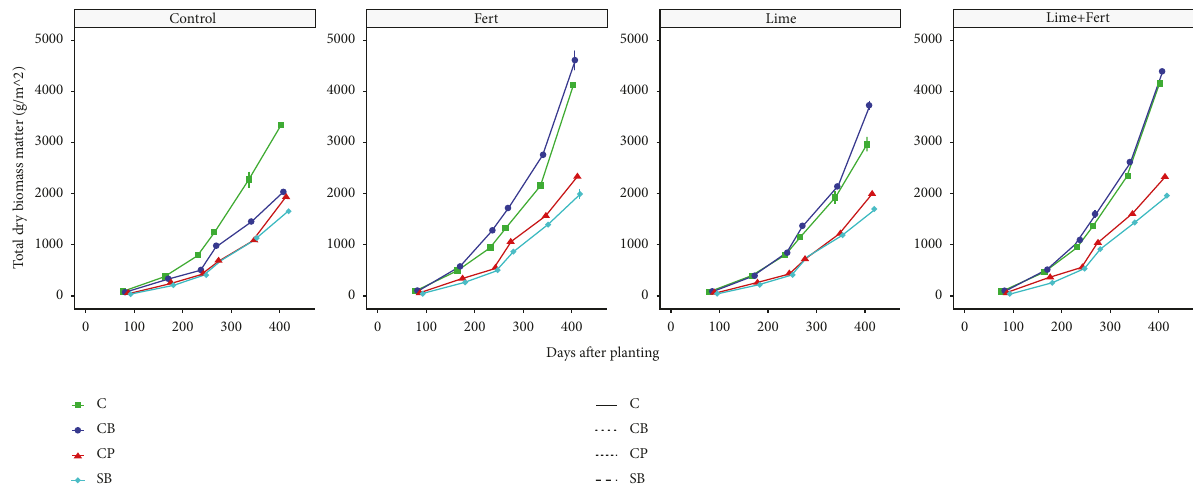
Figure 5: Effects of fertilizer on cassava total dry biomass (gm − 2 ) in monocropping (C), soybean (SB), common beans (CB), and cowpea (CP) intercropping pooled over two seasons (Fert-fertilized and Control-unfertilized+unlimed treatments).